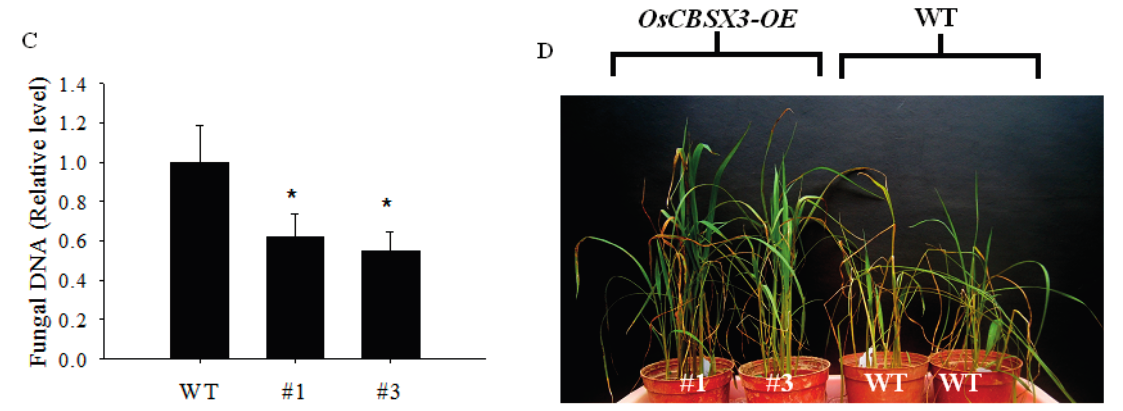
Figure 4. Over-expression of OsCBSX3 enhanced rice resistance to blast fungus. ( A ) Quantitative PCR analysis of OsCBSX3 expression in wildtpye (WT) and over-expression plants (#1 and #3). Data are means ± SE with three independent experiments. Asterisks indicate significant differences (Student–Newman–Keuls test, * p < 0.05 or ** p < 0.01); ( B ) Lesion in leaves at 6 dpi (days post inoculation). Numbers of expanding lesions (Els) with an area greater than 0.5 mm 2 per leaf and their mean areas were determined using ten leaves for WT and OsCBSX3 - OE plants. Values given are means ± SE; ( C ) The amounts of M. oryzae DNA in the WT and OsCBSX3 - OE rice leaves. The leaves were harvested at 6 dpi. Values were means ± SE of three independent experiments; ( D ) Symptom of rice